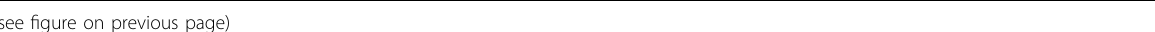
Fig. 1 Stress and glucocorticoid treatment decreased Ahi1 protein level. A Western blotting analysis of Ahi1 expression in the hypothalamus and hippocampus of mice after spatial restraint stress for 30 days. The ratios of Ahi1 to β -tubulin were presented beneath the blots (hypothalamus: t (8) = 8.208, *** P < 0.0001; hippocampus: t (8) = 4.336, *** P = 0.0025). n = 5 mouse brains per group. B Ahi1 mRNA in the hippocampus was examined by quantitative PCR after spatial restraint stress for 30 days ( n = 3 mouse brains per group). C Male ICR mice were treated without (Control) or with spatial restraint stress (Stress) for 4 weeks. After one week of stress, mice received antidepressant imipramine (i.p.) or saline (i.p.) daily for 3 weeks. After 3 weeks of treatment, the hypothalamus and hippocampus tissues were collected to analyze Ahi1 protein expression. β -tubulin was used as a loading control ( F (1,20) = 5.829, *** P < 0.0001; n = 6 mouse brains per group). D Serum corticosterone level was assayed by an ELISA method after spatial restraint stress for 30 days. ( t (18) = 3.996, ** P = 0.0008). n = 10 mice per group. E After Dex treatment for 21 days, Ahi1, Hap1, and GR levels in the hypothalamus was examined by western blotting (Ahi1: t (4) = 5.537, ** P = 0.0052; Hap1: t (4) = 3.787, * P = 0.0193; GR: t (4) = 6.031, ** P = 0.0038) ( n = 3 mouse brains per group). F PC12 cells were treated with Dex (20 μ M) or normal saline (Control) for 72 h, Ahi1, Hap1, and GR in PC12 cell lysates were detected by western blotting (Ahi1: t (4) = 4.428, * P = 0.0114; Hap1: t (4) = 3.194, * P = 0.0331; GR: t (4) = 3.308, * P = 0.0297. n = 3 cell samples). G Ahi1 mRNA levels were quanti fi ed by quantitative PCR in the hypothalamus samples ( n = 3 mouse brains) from Dex-treated mice for 21 days ( t (4) = 0.9397, P > 0.05) or cell samples from Dex-treated PC12 ( n = 3 cell samples) for 72 h, ( t (4) = 0.4929, P > 0.05). The transcript levels of Ahi1 were expressed as fold changes relative to GAPDH (mice) or actin (PC12 cells). All the data are presented as mean ±